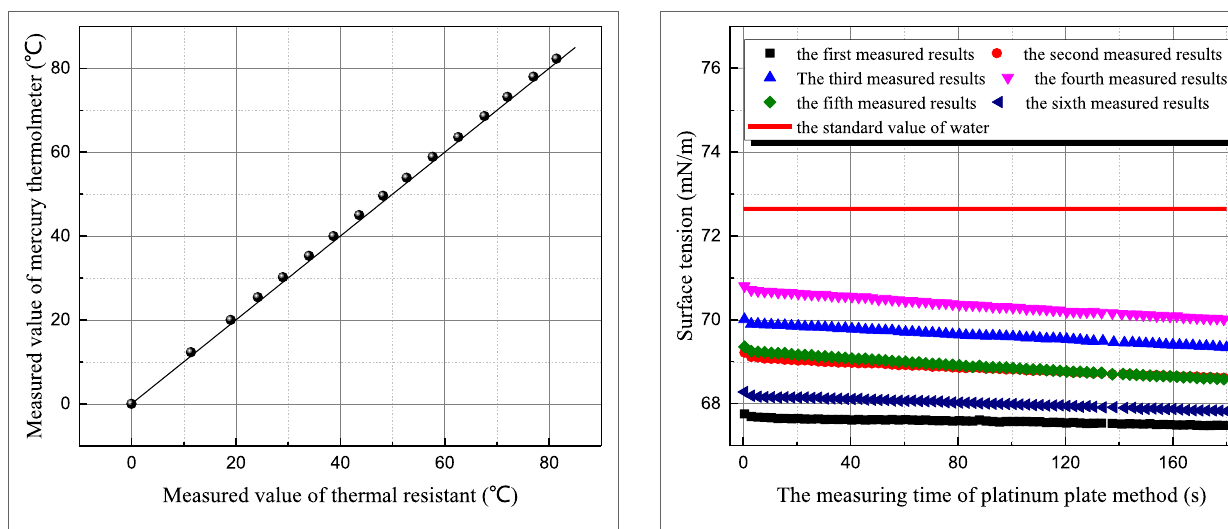
FigUre 2 | The relationship of measured temperature value by thermal resistant and mercury thermometer.